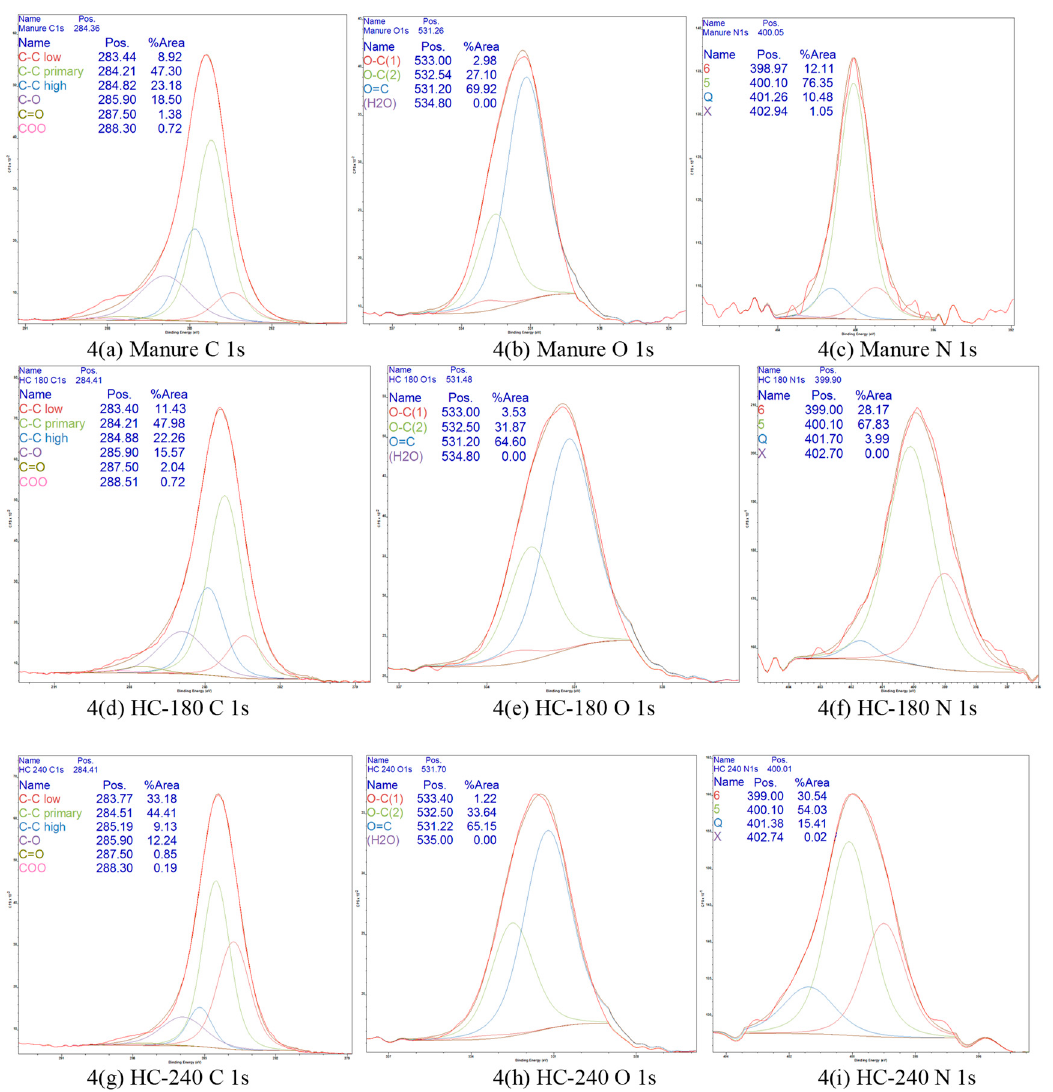
Figure 4. Deconvoluted C, O, and N peaks from XPS analysis of manure and hydrochars (C–C low: cyclopentanes, C–C primary: cyclohexanes, C–C high: cycloheptanes, 5: pyridinic, 6: pyrrolic, Q: quaternary nitrogen, and X: pyridine-N-oxide).